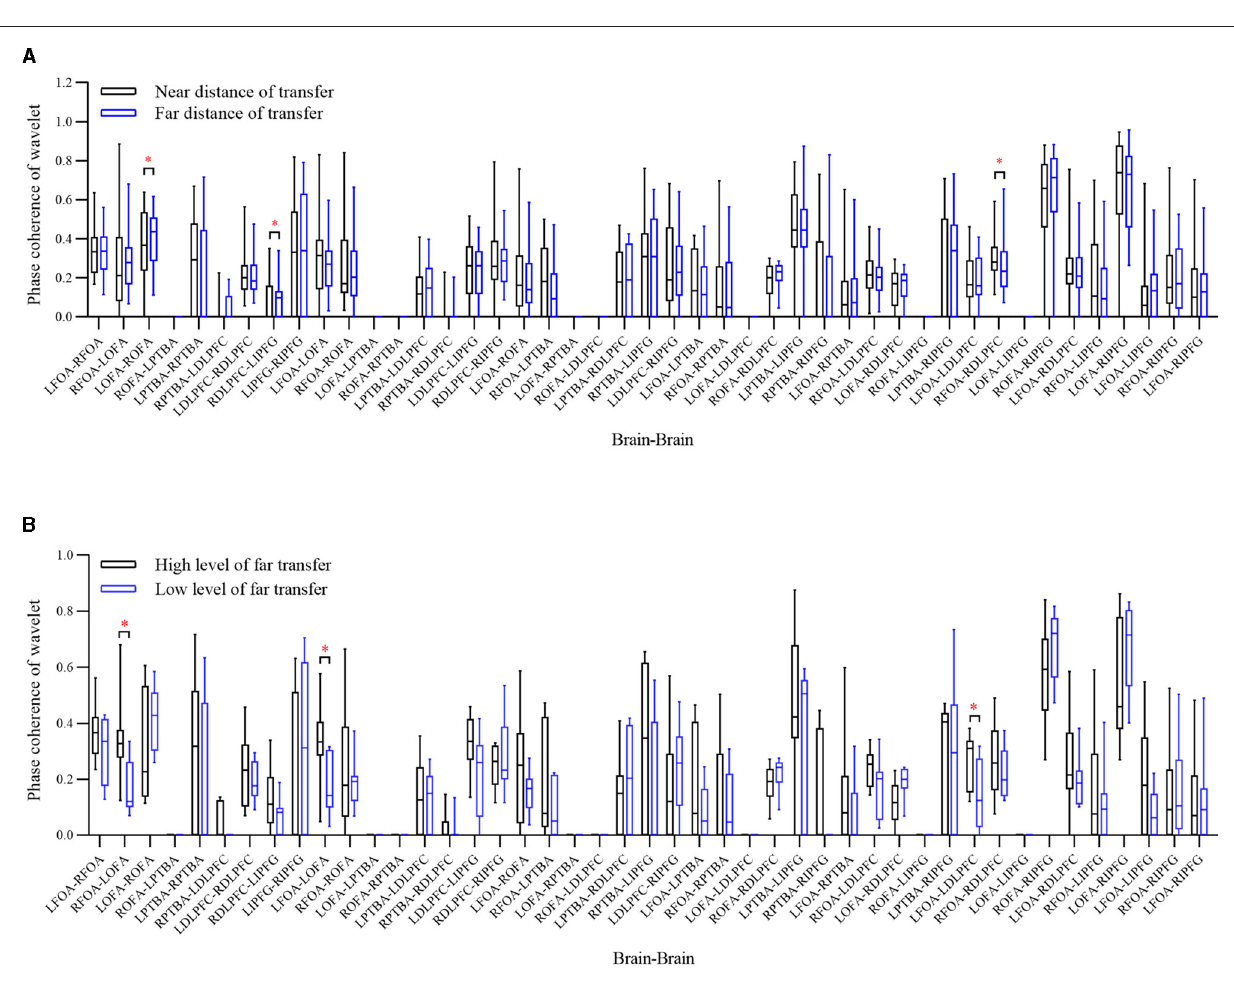
FIGURE 9 | Box diagram of significant differences in wavelet amplitude. (A) At different knowledge transfer distances; (B) at different prior cognitive levels. ***Sig. < 0.001; **Sig. < 0.01; *Sig. <